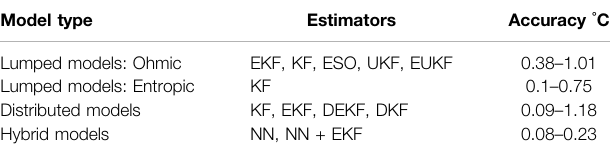
TABLE 5 | Comparison of soft sensors. Model type Lumped models: